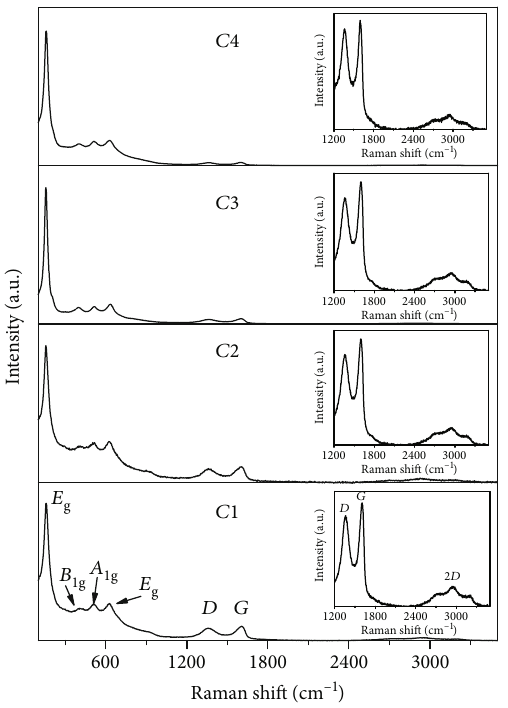
Figure 5: Raman spectra of the four compounds to check the active vibrational modes of the composite TiO